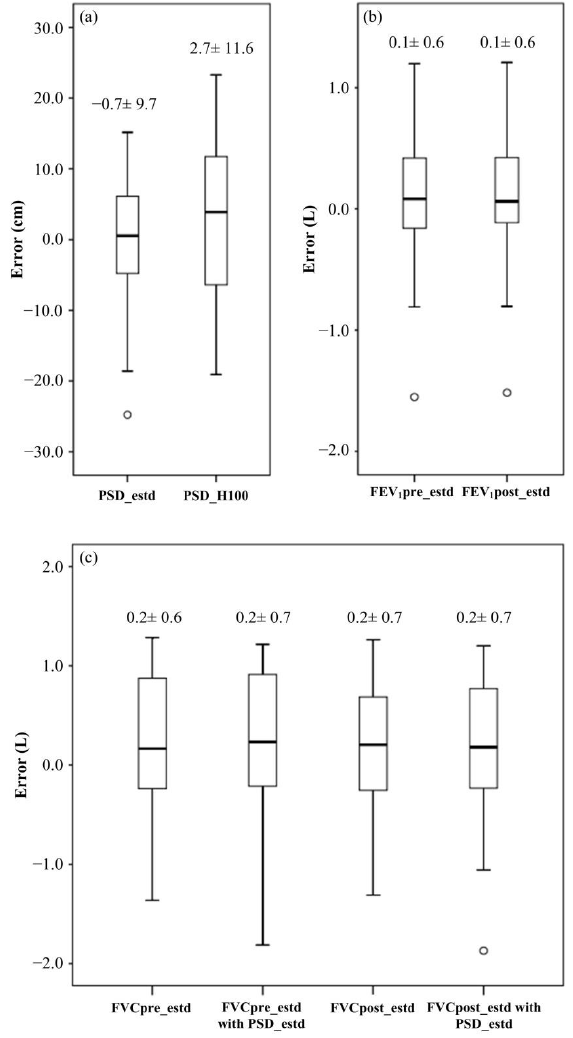
Figure 3. The box plot of predicted errors for the validation set. ( a ) Per step distance; ( b ) FEV 1 ; ( c ) FVC. Note that the circle symbols represent the outliers. Table 3. The predicted accuracy for obstruction (FEV 1 /FVC < 70%) in the validation set ( n = 30) with the proposed estimated models.